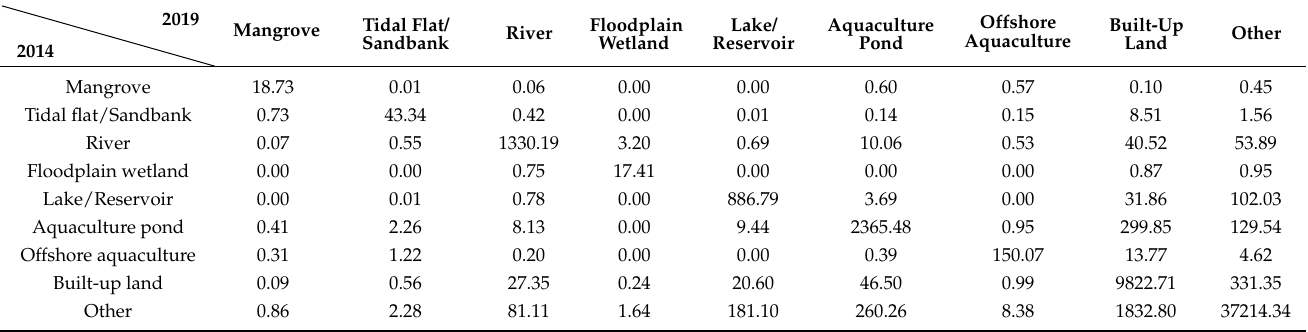
Table A4. Transfer matrix of each land cover type in the GBA from 2014 to 2020 (km 2 ).